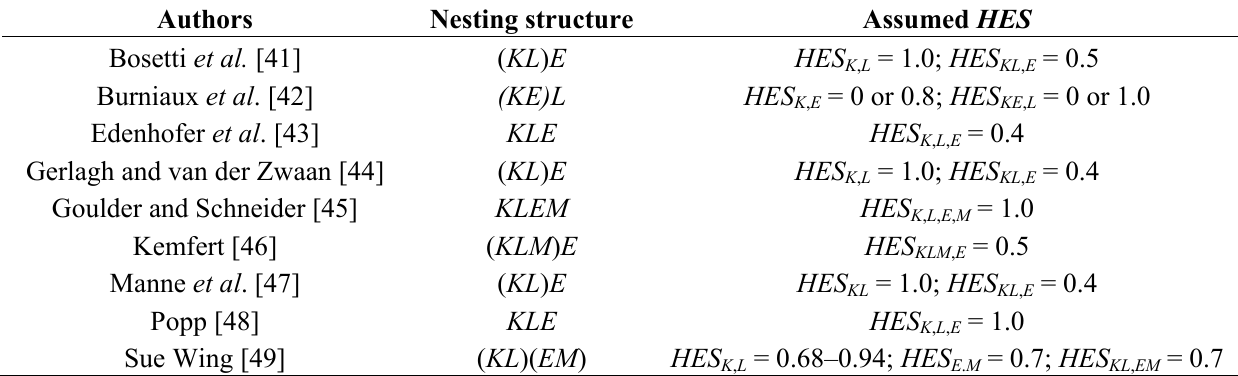
Table 2. Nesting structures and assumed values of the Hicks elasticity of substitution ( HES ) in a selection of contemporary CGE models. Source: based on van der Werf